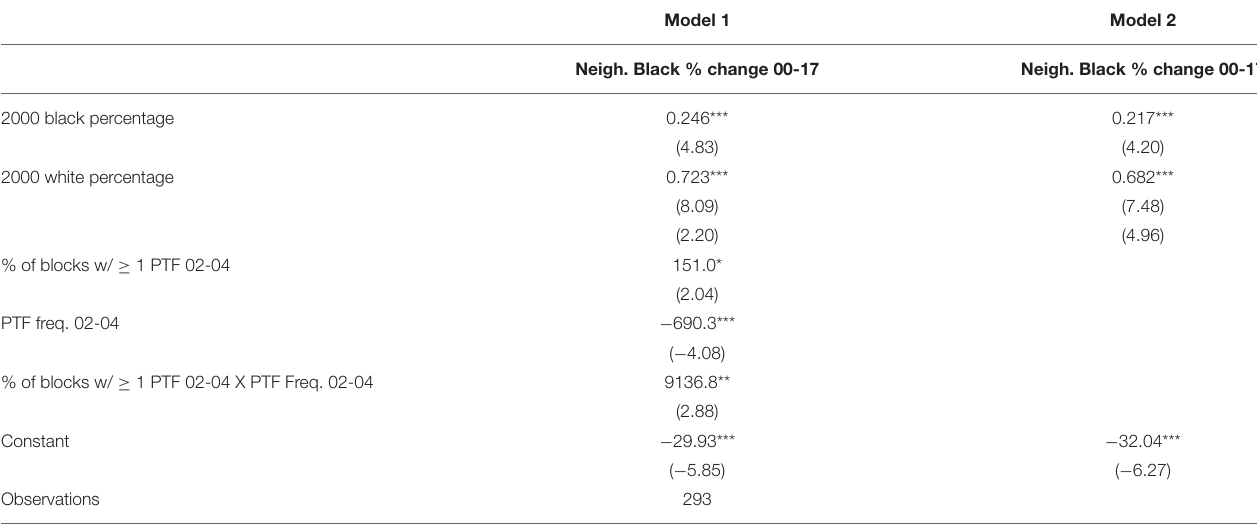
TABLE 6 | Demographic change